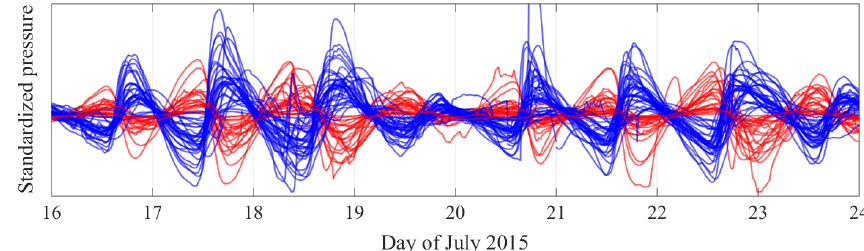
Figure 5. Diurnal residuals during 8d for 50 sensors belonging to a hydraulic cluster. The two subclusters are presented in red and blue.